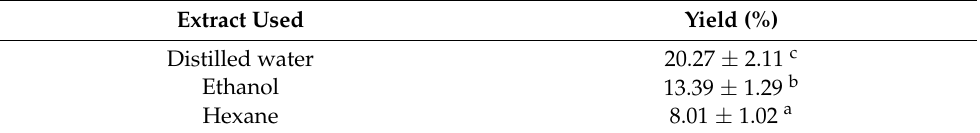
Table 1. Percentage yield of dried Cleistocalyx nervosum var. paniala fruit extracts. Extract Used